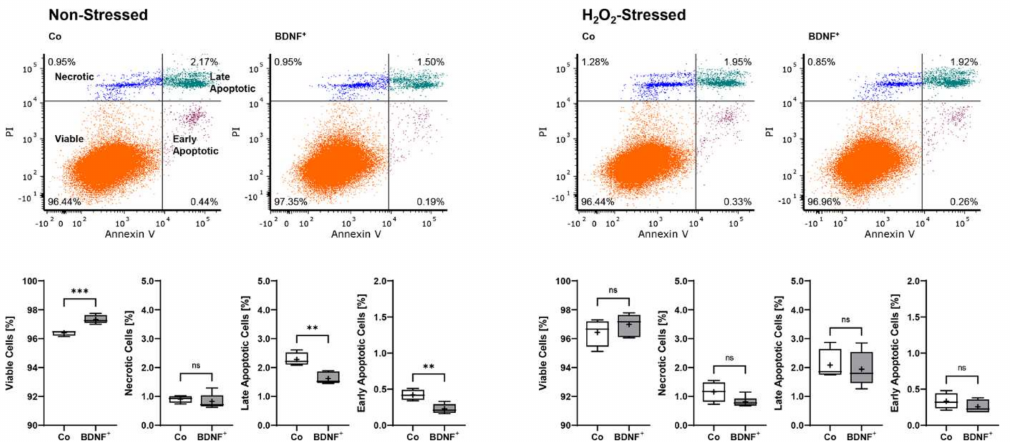
Figure 4. Apoptosis rate in BDNF-transfected ARPE-19 cells without or after H 2 O 2 -induced oxidative stress compared to non-transfected control cells. Non-transfected cells (Co, n = 8 cultures) and BDNF-transfected cells (BDNF + , transfected with 0.03 µ g SB100X transposase and 0.47 µ g